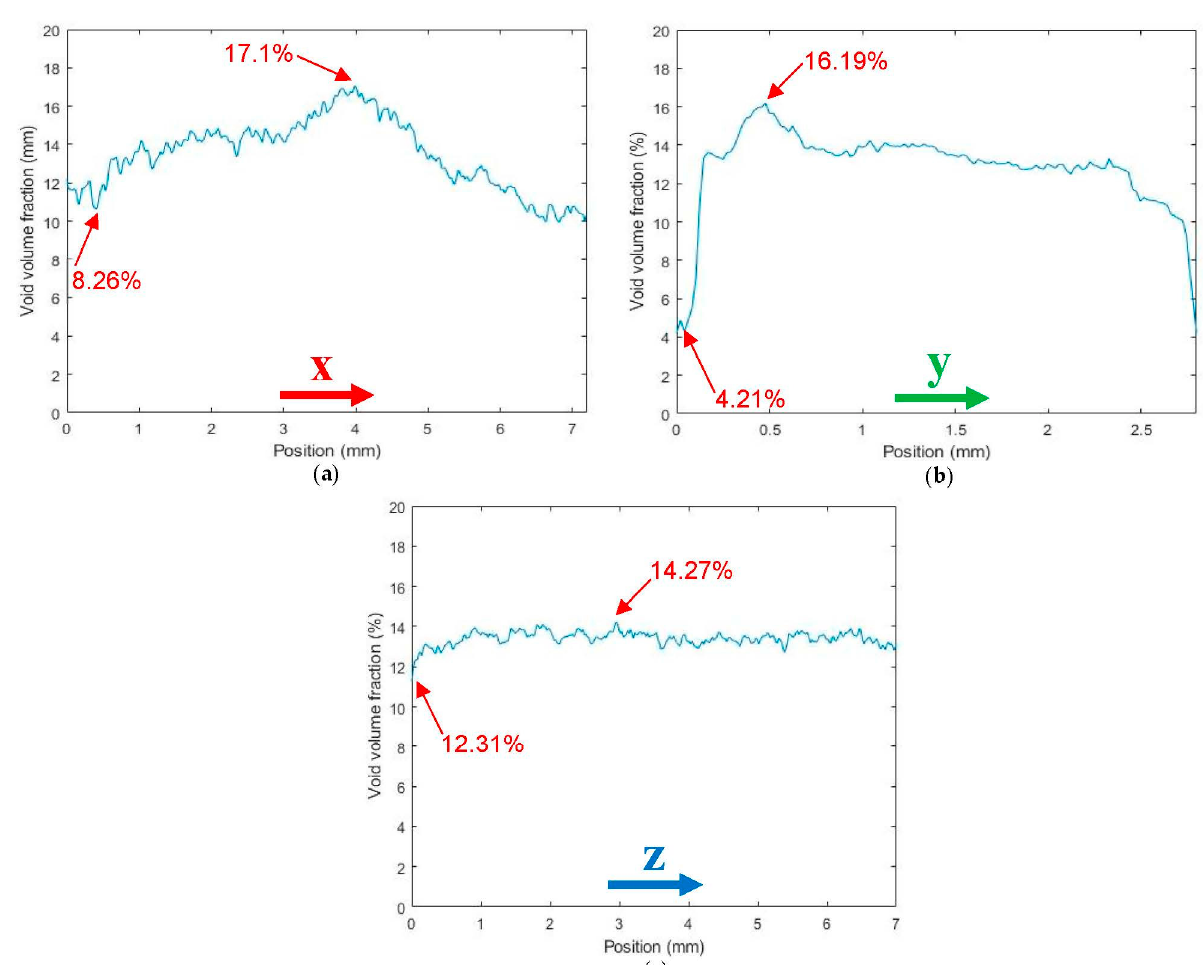
Figure 7. Void volume fraction along the coordinate directions of a SCF/ABS regularly deposited single bead: ( a ) along the X-direction; ( b ) along the Y-direction; ( c ) along the Z-direction.